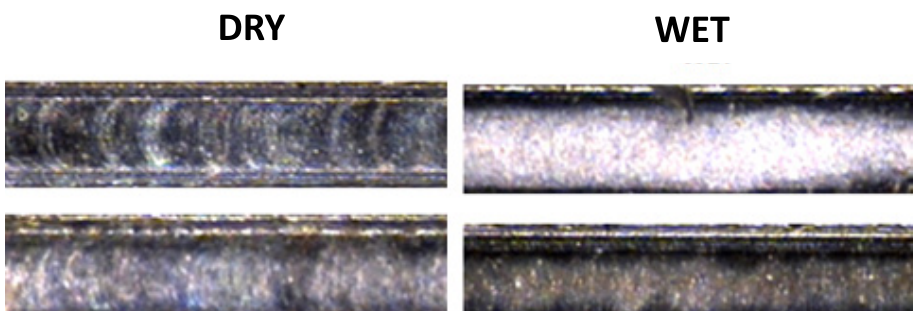
Figure 16. Coolant application for minimizing roughness in AISI 316L.